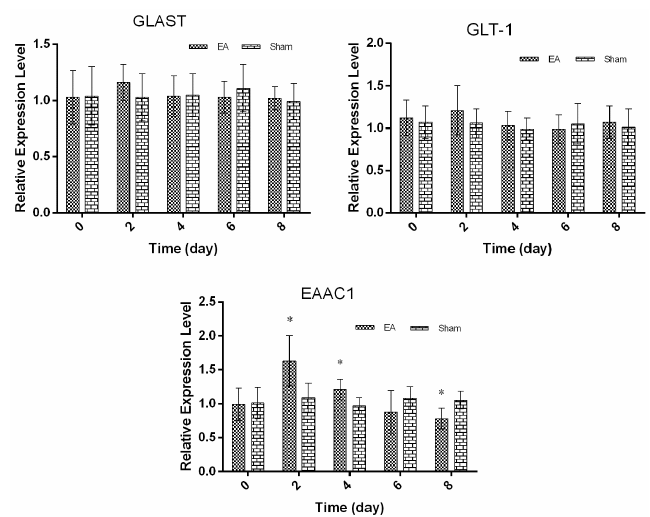
Figure 3. The protein expression levels of the spinal GTs after single EA (Mean ± SD, n = 6). Samples were collected from the L4-5 segment of spinal cord. The significance of differences was calculated by a t -test. * p < 0.05 compared with 0 h within the same group.